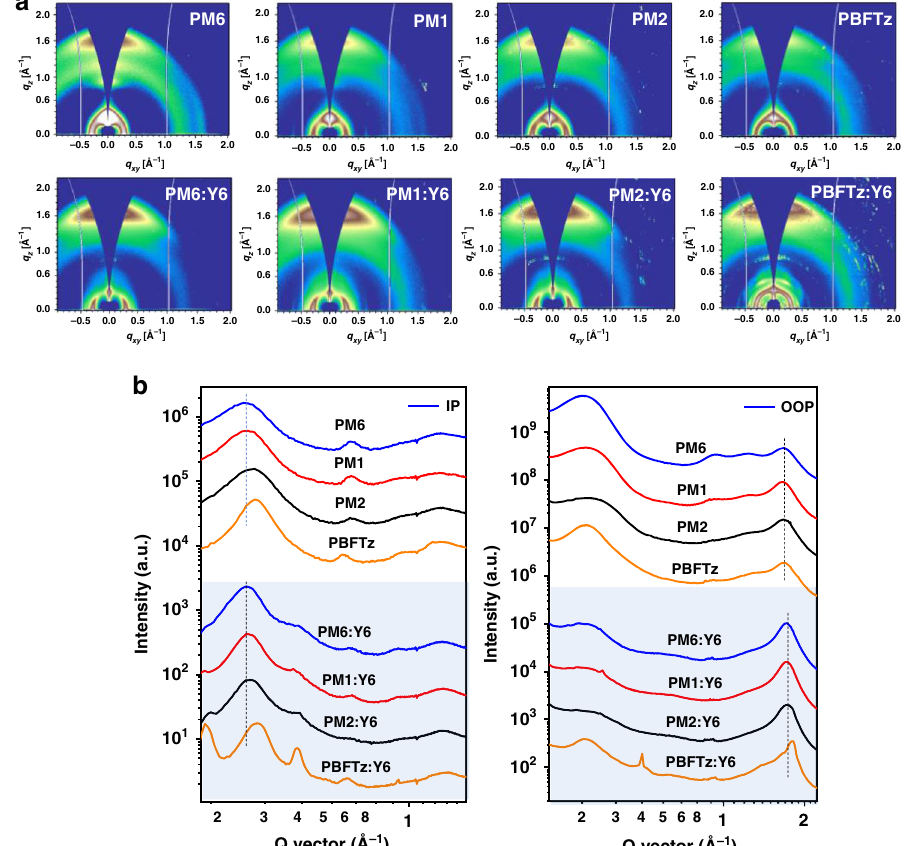
Fig. 3 Molecular packing properties. a 2D GIWAXS patterns for neat polymers and blend fi lms. b Scattering pro fi les for neat polymers and blend fi lms under optimal